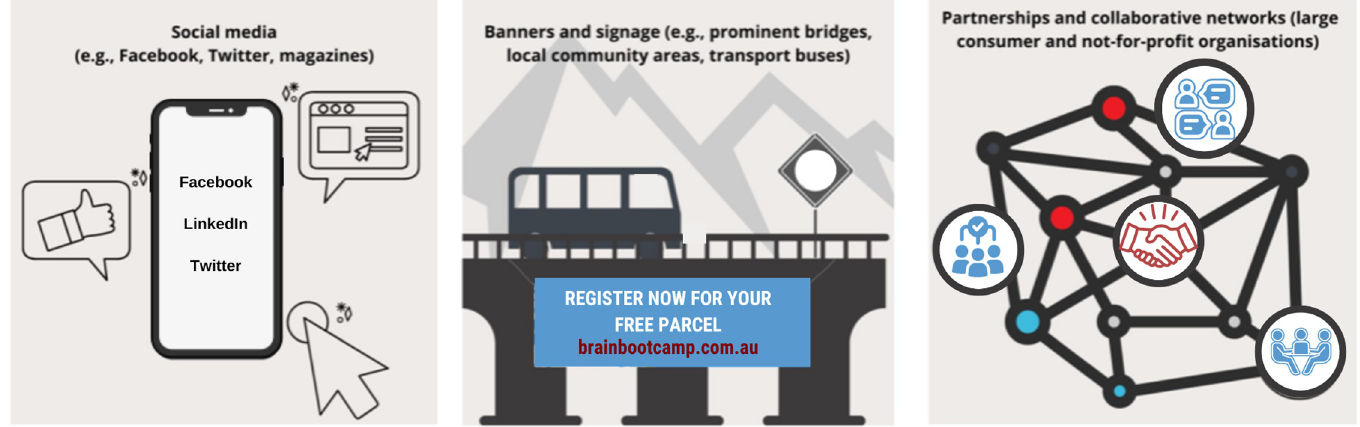
Fig 1. Graphical representation of the study’s advertising strategy (Source: Brain Bootcamp Research Team, Macquarie University, Australia).